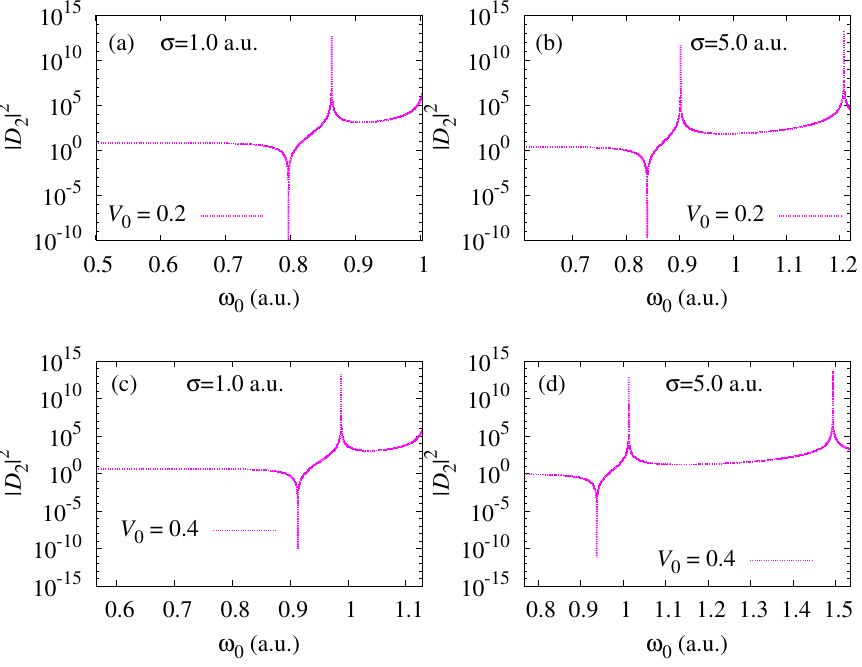
Figure 8. Variation of two-photon 1 s → 3 s absorption coefficients with frequency of incoming photons, ω 0 , for r 0 = 40 a.u. for ( a ) V 0 = 0.2 a.u. and σ = 1.0 a.u.; ( b ) V 0 = 0.2 a.u. and σ = 5.0 a.u.; ( c ) V 0 = 0.4 a.u. and σ = 1.0 a.u.; ( d ) V 0 = 0.4 a.u. and σ = 5.0